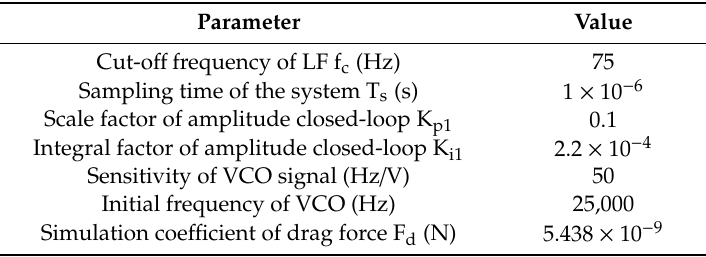
Figure 6. Diagram of the control and measurement system. Table 3. Simulation parameters.